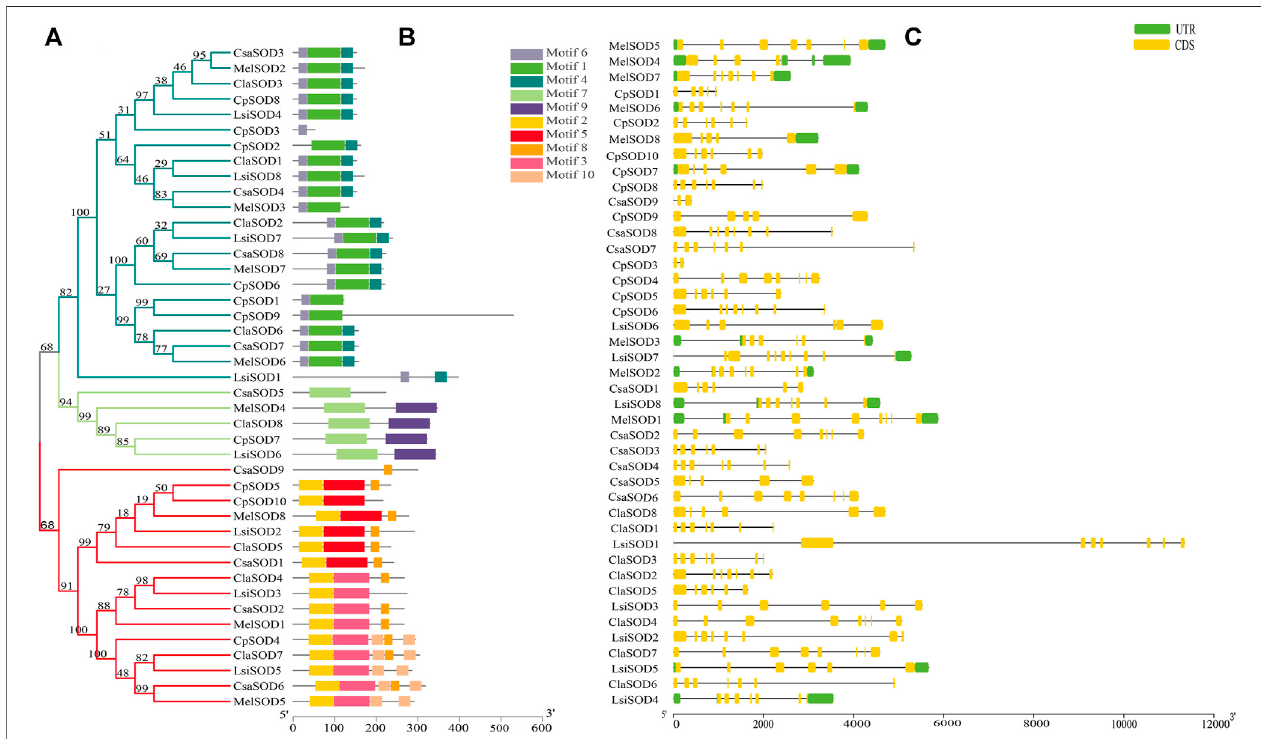
FIGURE 2 | (A) The protein structures of SODs based on the presence of conserved motifs were arranged corresponding to the phylogenetic tree. (B) All conservedmotifsoftheSODproteinswereidenti fi edbytheMEMEprogram.Differentmotifsarehighlightedwithdifferentcoloredboxeswithnumbers1to10. (C) Gene structures of SODs exons are shown as yellow boxes, introns are shown as thin black lines, and UTRs are shown as blue boxes.